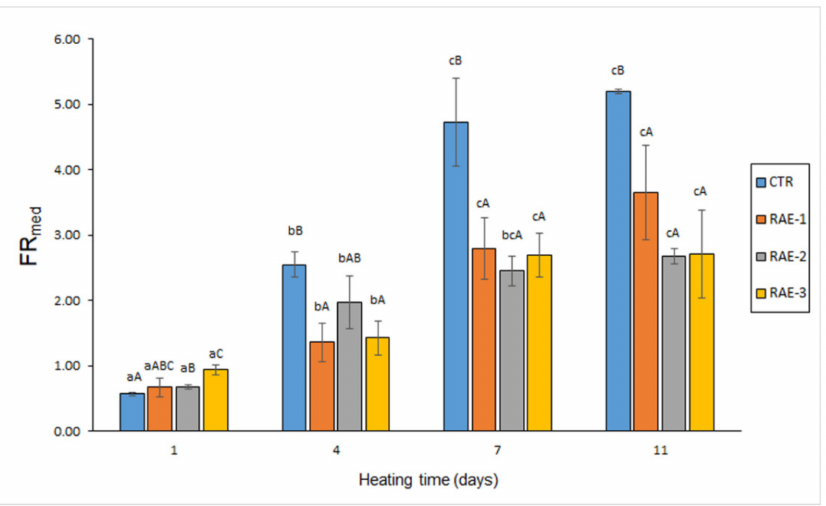
Figure 3. The evolution of fluorescent compound content in the liquid medium (FR med ) resulting from fish muscle heating in the presence of red alga extract (RAE). Abbreviations of RAE concentrations as expressed in Table 1. Mean values of three independent determinations ( n = 3); standard deviations are shown by bars. Mean values accompanied by lowercase (a–c) letters denote significant differences ( p < 0.05) as a result of heating time; mean values accompanied by capital letters (A–C) denote significant differences ( p < 0.05) as a result of RAE